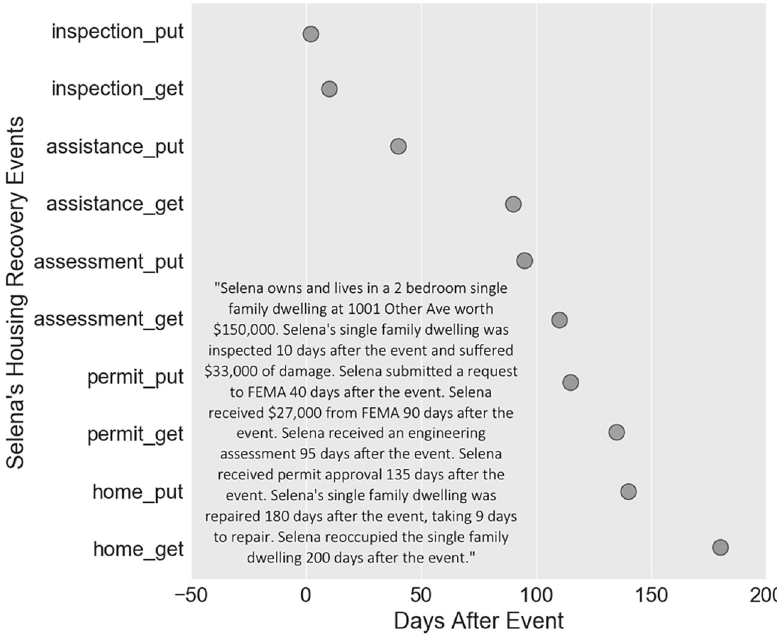
Fig. 1 Illustration of a process-based discrete event simulation of recovery. The vertical dimension represents increasing time in the downward direction. Rectangles represent processes with a proba- bilistic duration associated with one or more discrete events. Icons Fig. 2 Entity-scale output